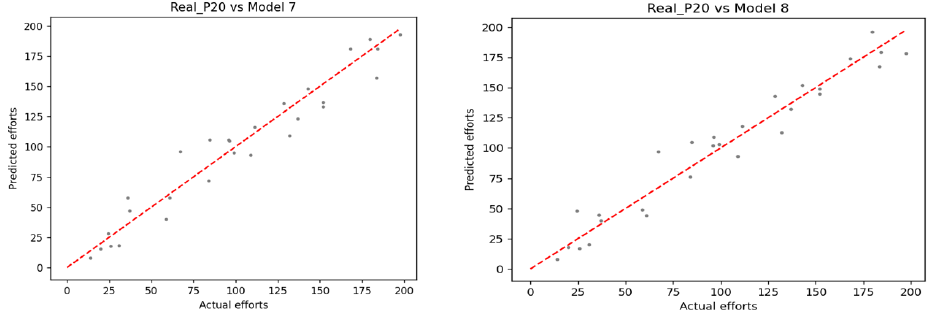
Figure 5. The scatter of predictive efforts vs. actual efforts: Model 7 vs.